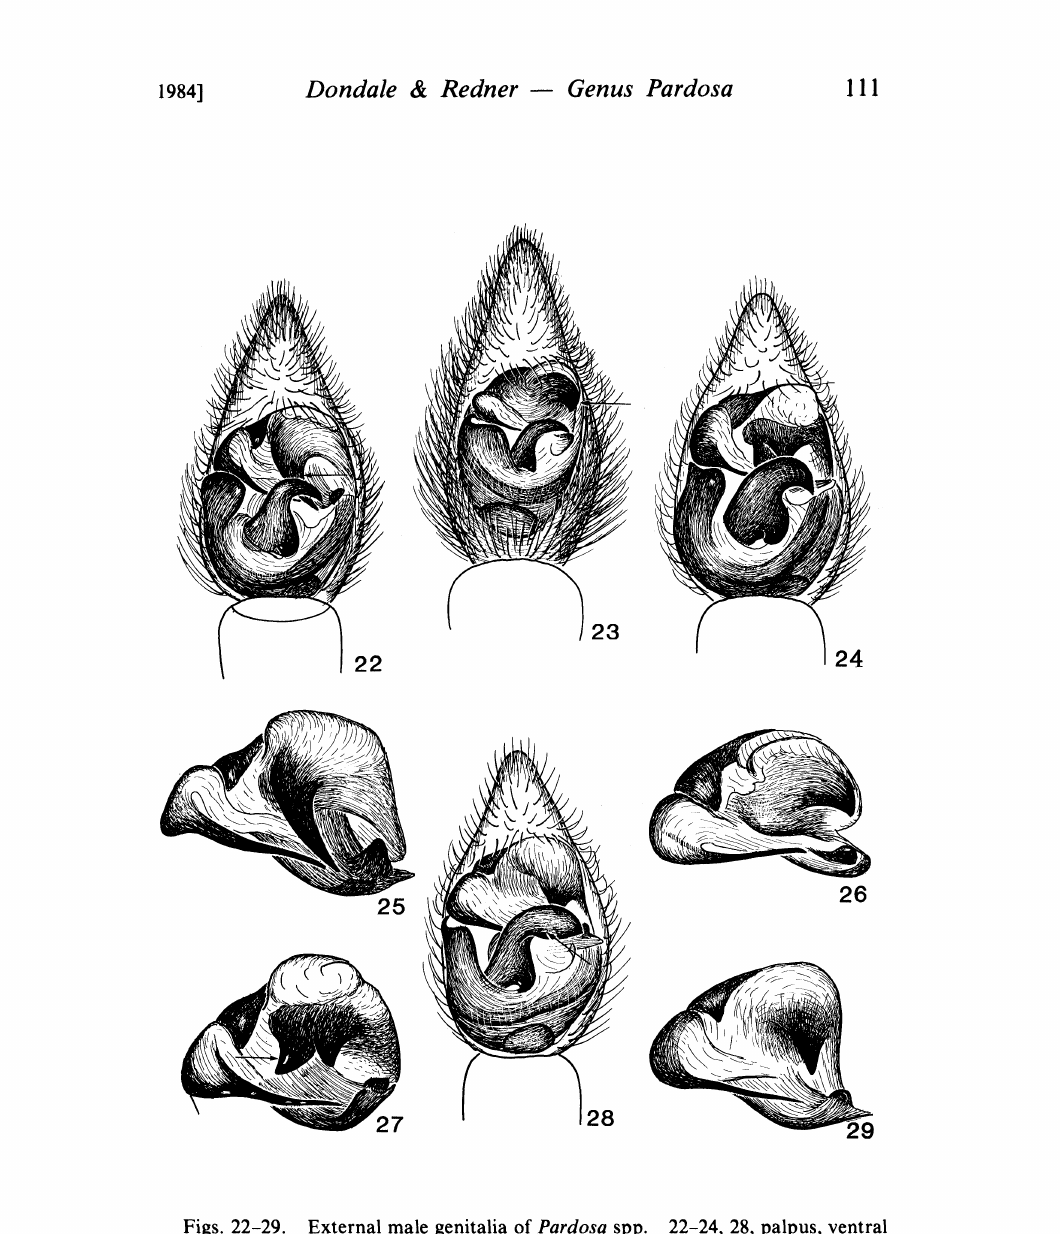
Figs. 22-29. External male genitalia of Pardosa spp. 22-24, 28, palpus, ventral view. 25-27,29, apical division, ventral view. 22,25, P. littoralis Banks. 23,26,